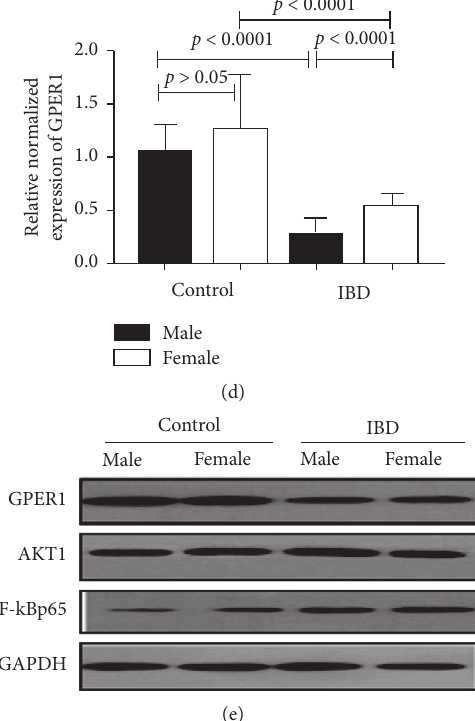
Figure 2: GPER1 is associated with gender differences in IBD patients. (a) Representative immunohistochemical (IHC) staining of the estrogen receptor protein in tissue (400 × ). (b) The mRNA expression of estrogen receptor ER α , ER β (c), and GPER1 (d) in tissue. (e) The expression of GPER1, AKT1, and NF- κ Bp65 is assessed by a western blot. The values are presented as the mean ± SEM.